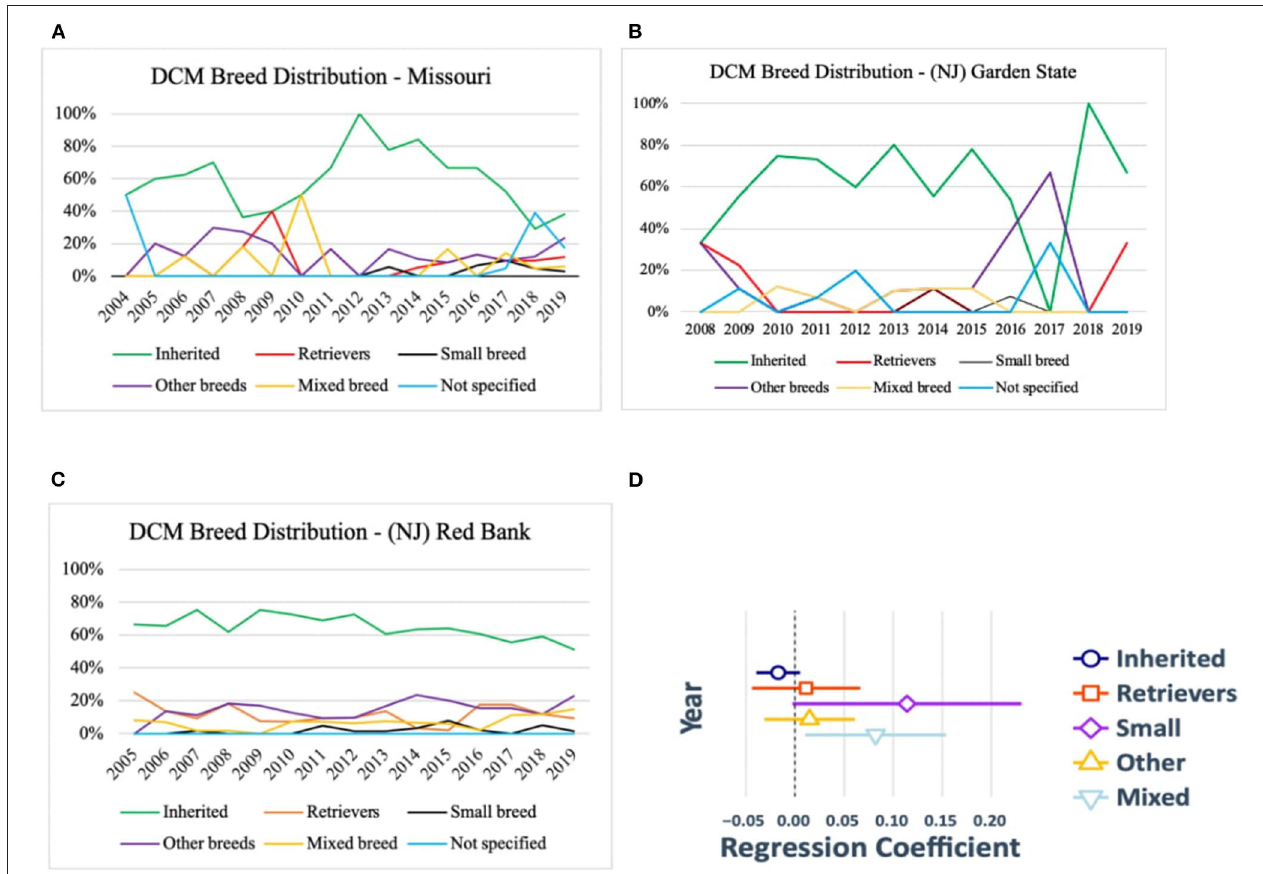
FIGURE 3 | (A–D) Annual breed distribution scatter plots from three different cardiology services: University of Missouri (A) , Red Bank—New Jersey (B) , and Garden State (GS)—New Jersey (C) . Breeds with a known genetic link to dilated cardiomyopathy (DCM) (Inherited group—dark blue) are the most diagnosed with DCM, with all other categories generally being represented less frequently each year, in all three hospitals. The number of dogs in each group was regressed against year, total DCM cases, and site. Open icon denotes regression coefficient, with lines representing individual confidence intervals. The Mixed Breed group had a slightly increasing trend, which was statistically significant ( P = 0.025, RC = 0.082). Small and Other groups were not significant ( P = 0.055, RC = 0.011; P = 0.053, RC = 0.015, respectively). Retrievers did not show a trend over the years ( P = 0.689, RC = 0.0112). The Inherited group showed a slight negative trend, which was not significant ( P = 0.134, RC = − 0.017) (D)